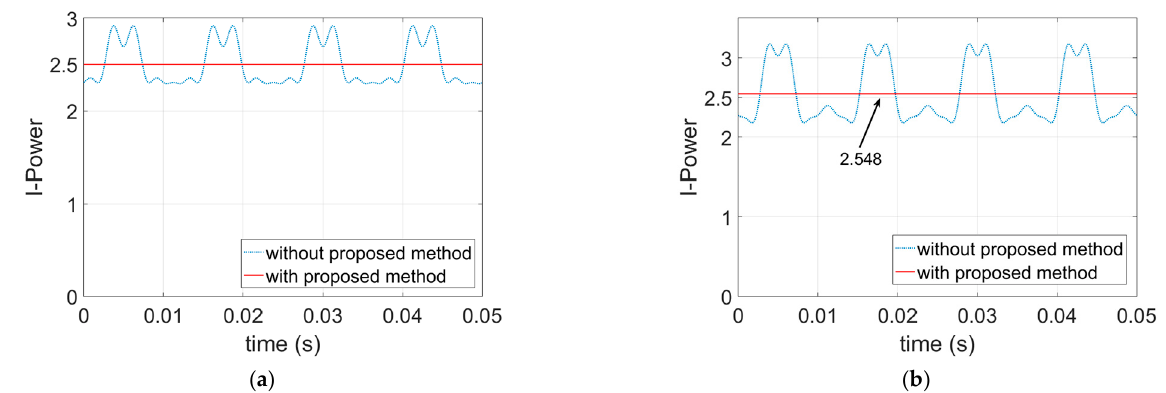
Figure 6. I-power graphs for the nonadjacent double-phase OCFT condition currents: ( a ) Fundamental; ( b ) fundamental plus third harmonic.